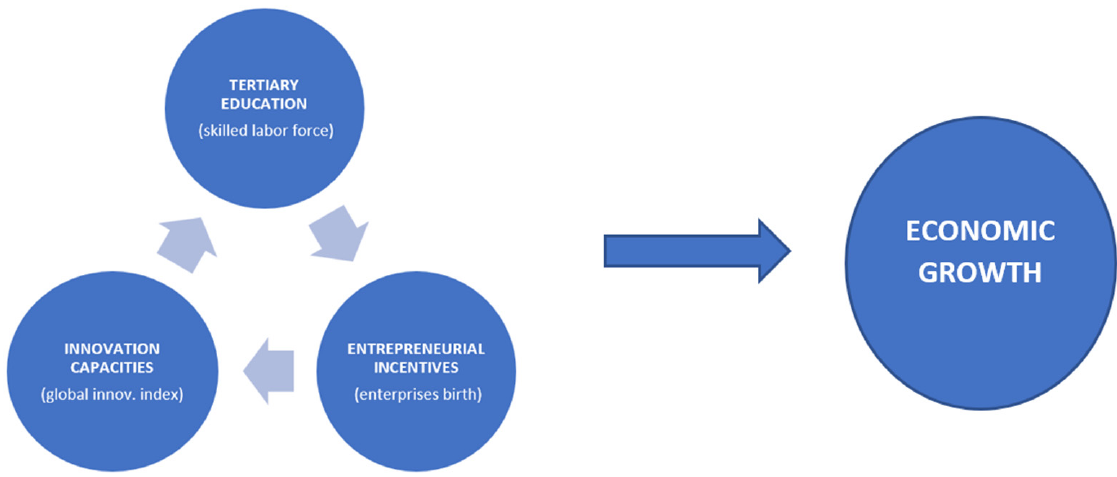
Figure 1. Integrated framework of economic growth. Source: Adapted by authors.